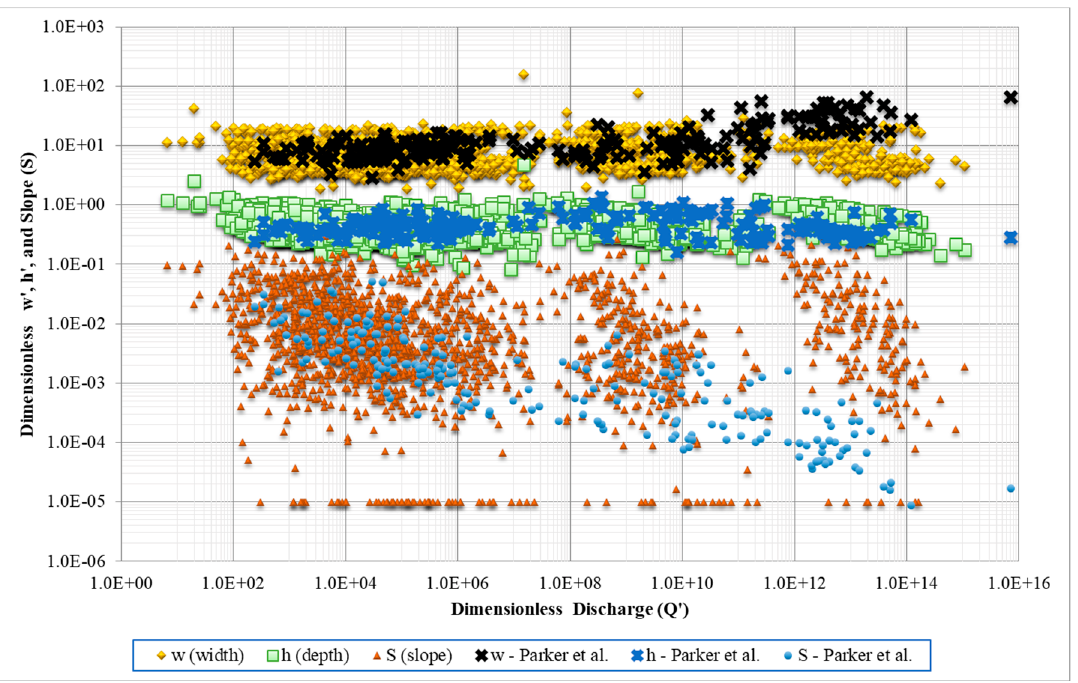
Figure 4. Dimensionless bankfull width, dimensionless bankfull depth, and channel slope plotted as a function of dimensionless bankfull discharge. Bankfull discharge estimated using Simon et al. [46] were overlaid with data points provided by Parker et al. [48].